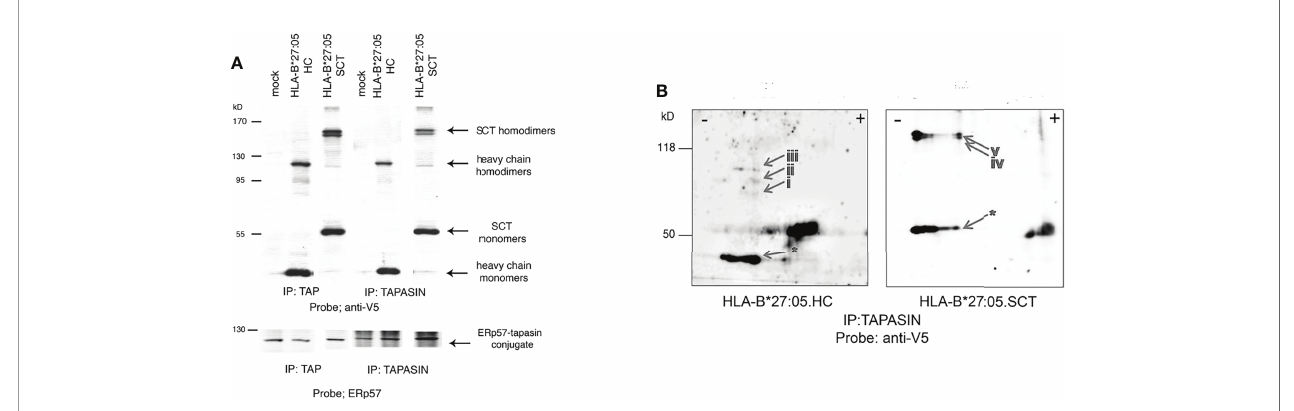
FIGURE 3 | HLA-B*27:05 monomeric and dimeric complexes can associate with ER resident chaperones and within the PLC. (A) TAP and tapasin immunoprecipitations immunoblotted for HLA-B*27:05.HC and HLA-B*27:05.SCT reveal that both dimers and monomers can be detected within the PLC. HLA- B*27:05.SCT and HLA-B*27:05.HC dimers and monomers are indicated with arrows. TAP and tapasin immunoprecipitates were probed with ERp57, highlighting the ERp57-tapasin conjugate. (B) Two-dimensional isoelectric focusing gel analysis of tapasin immunoprecipitates immunoblotted with anti-V5 antibody reveal that both